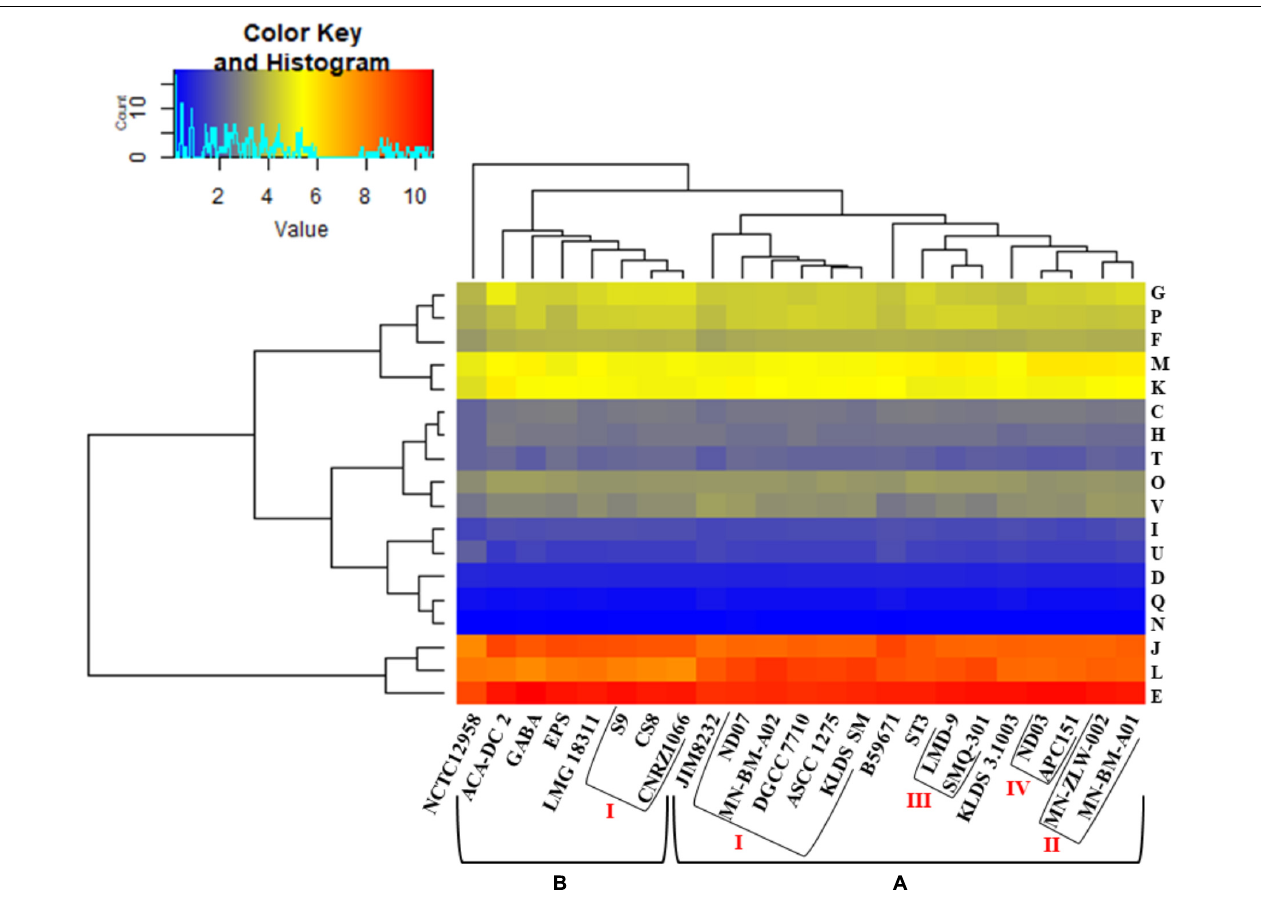
FIGURE 4 | Clusters of orthologous groups (COG) frequency heat map based on a two-dimensional hierarchical clustering. The horizontal axis corresponds to the percentage frequency of proteins involved in the respective COG functional categories: Information storage and processing: translation, ribosomal structure, and biogenesis (J), transcription (K), replication, recombination, and repair (L); cellular processes and signaling: cell cycle control, cell division, chromosome partitioning (D), cell wall/membrane/envelope biogenesis (M), cell motility (N), post-translational modification, protein turnover, chaperones (O), signal transduction mechanisms (T), intracellular trafficking, secretion, and vesicular transport (U), defense mechanisms (V); metabolism: energy production and conversion (C), amino acid transport and metabolism (E), nucleotide transport and metabolism (F), carbohydrate transport and metabolism (G), coenzyme transport and metabolism (H), lipid transport and metabolism (I), inorganic ion transport and metabolism (P), secondary metabolites biosynthesis, transport and catabolism (Q). The vertical axis shows the 23 S. thermophilus strains. Strains were grouped in two clusters (A,B) . Subgroups within the clusters are also highlighted (AI, AII, AIII, AIV, and BI). Categories R and S, concerning poorly characterized proteins, were not included in the